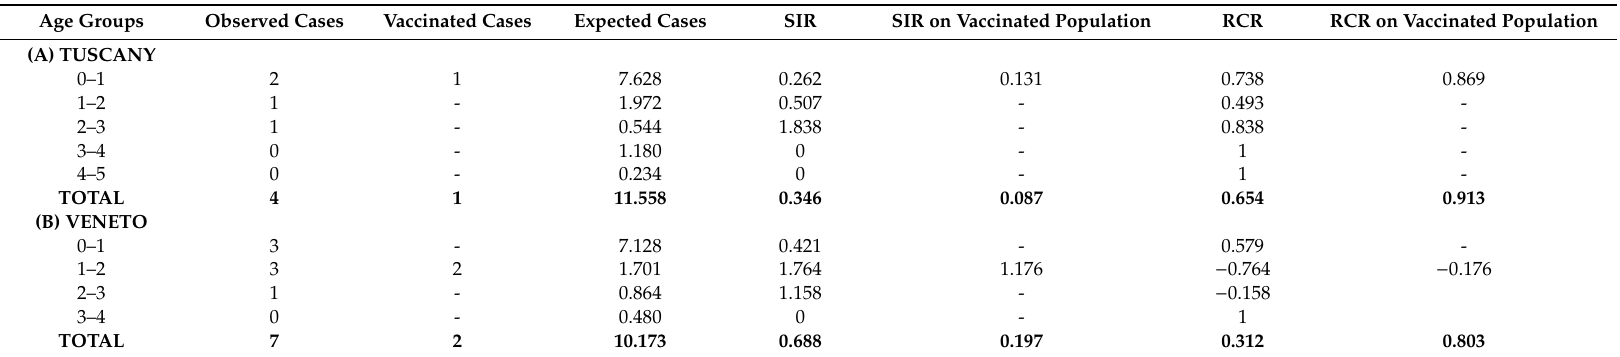
Table 4. Standardized Incidence Ratio and Relative Case Reduction in Neisseria meningitidis B cases (vaccinated or not) in Tuscany and